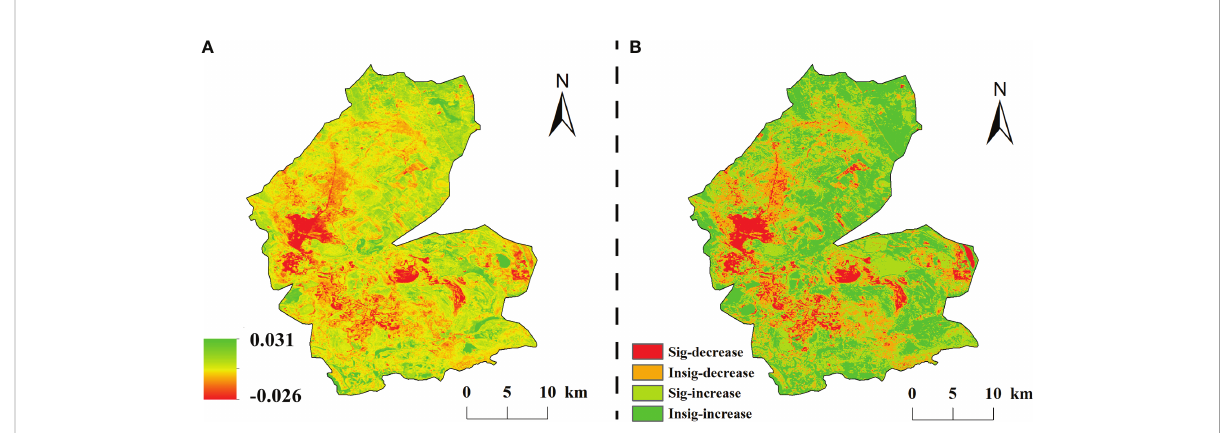
FIGURE 4 The classi fi cation of change trend in the study area from 1984 to 2020. (A) is the slope of interannual variation of NDVI, (B) is the spatial distribution of signi fi